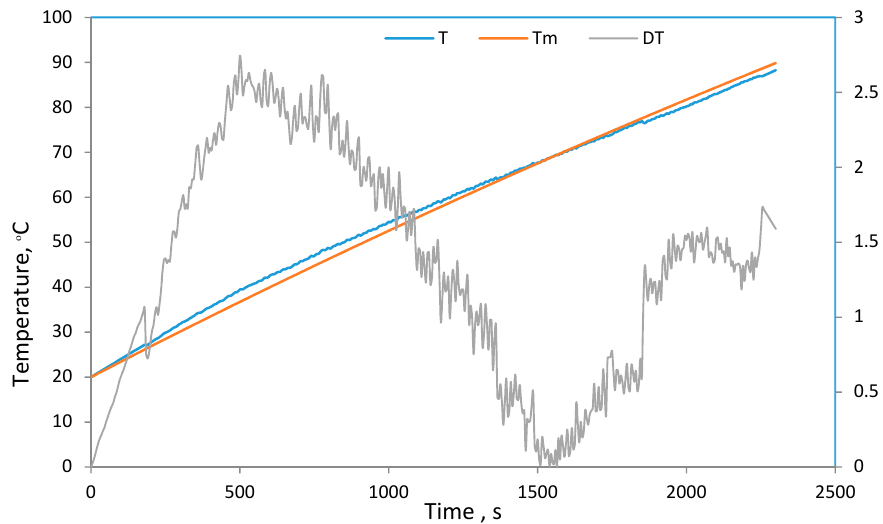
Figure 4. Verification of the temperature model with an indication of the course of absolute error.